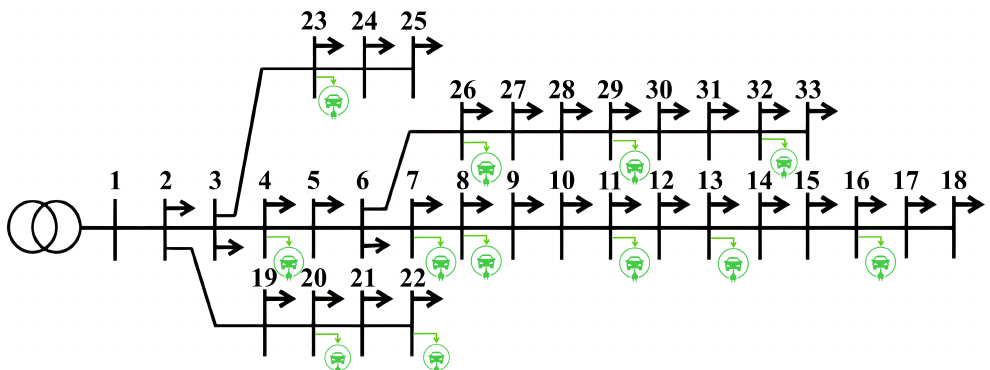
Figure 1. Employed modified IEEE 33-bus distribution